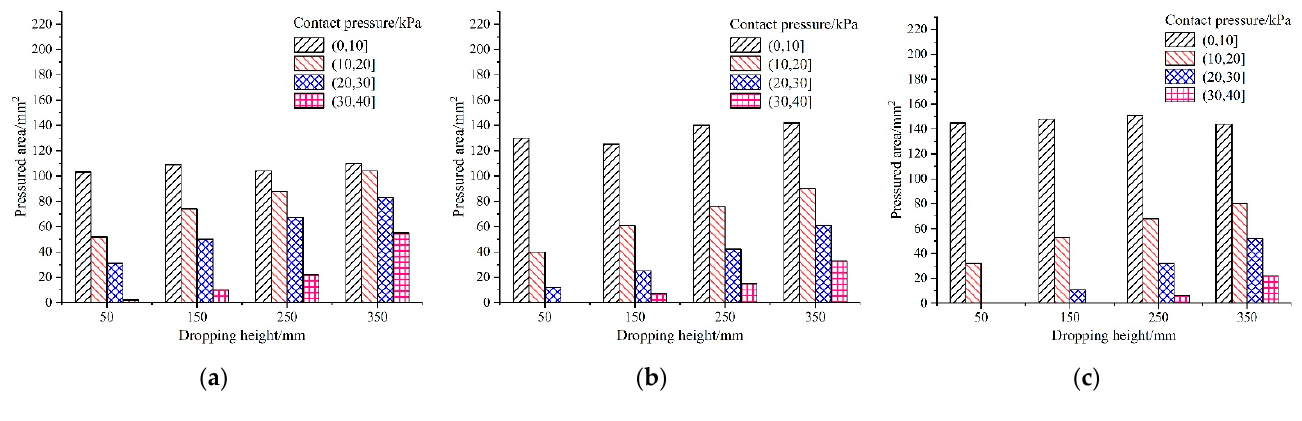
Figure 8. Pressured area distribution at different drop heights for three collision materials: ( a ) steel, ( b ) soil blocks, and ( c ) ABS plastic. ( b ) soil blocks, and ( c ) ABS plastic.